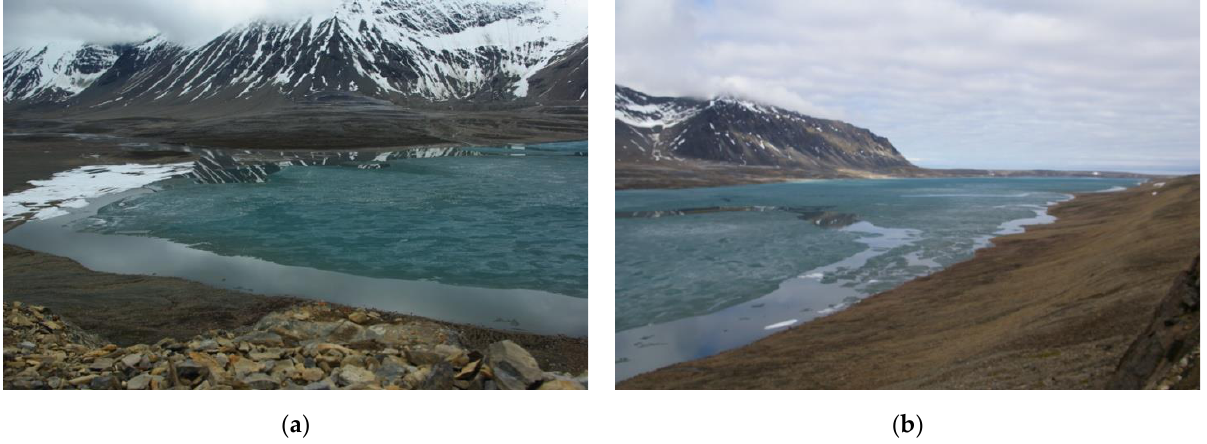
Figure 2. ( a ) Example image from the “Plume” camera from 25 June 2016 at 11:30 local time, showing the southeast portion of the lake during ice break-up. Patchy lake ice (which appears in blue-green color in the image) is present on the lake surface, surrounded by a moat of open water along the shoreline. ( b ) Same as ( a ), but for the “North” camera, that looks northwest along the long axis of the lake. In this particular year, BUE (the first date when ice was no longer visible on the lake surface) was observed on June 30.